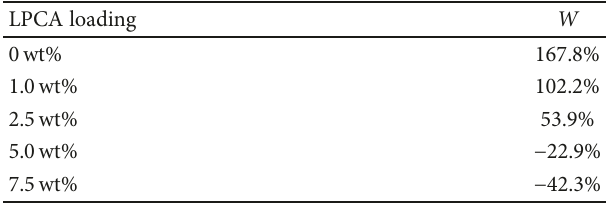
Figure 1: The photos of LPCA-WPU elastomers immersed in water after 12 h. Table 2: The percentage of the weight change of LPCA-WPU elastomers with di ff erent loadings of